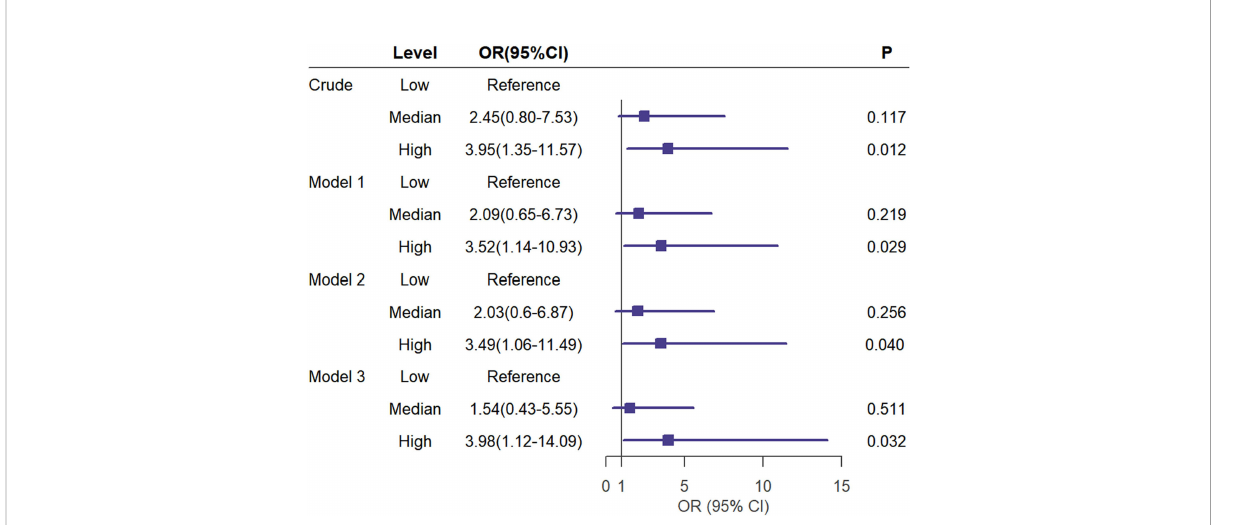
FIGURE 3 Univariate (crude model) and multivariate analyses (Model 1 to 3) for logistic regression of CKD(eGFR < 60ml/min/1.73m2) risk according to the tertiles of the renal FF. Model 1 was adjusted for age and sex. Model 2 was adjusted for the BMI,WC,HbA1C,TG in addition to the variables in model 1. Model 3 was adjusted for duration of diabetes mellitus, history of hypertension,smoking history,drinking history,insulin therapy, RX with ACE-I/ARBs, hypolipidemic therapy in addition to the variables in model 2.